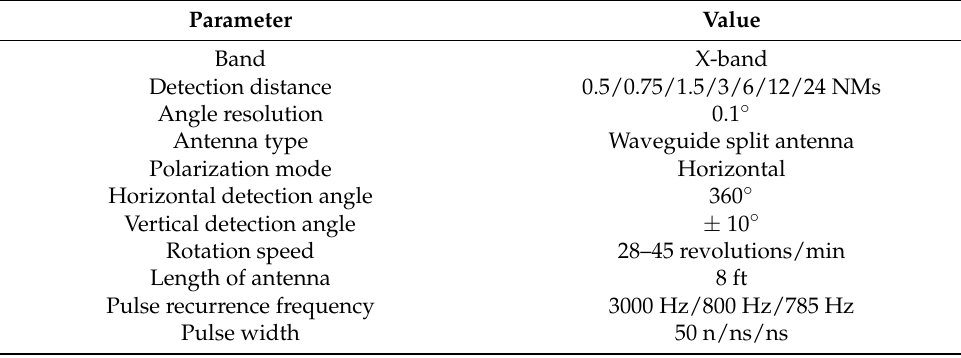
Table 1. The parameters of the Sperry Marine radar system.